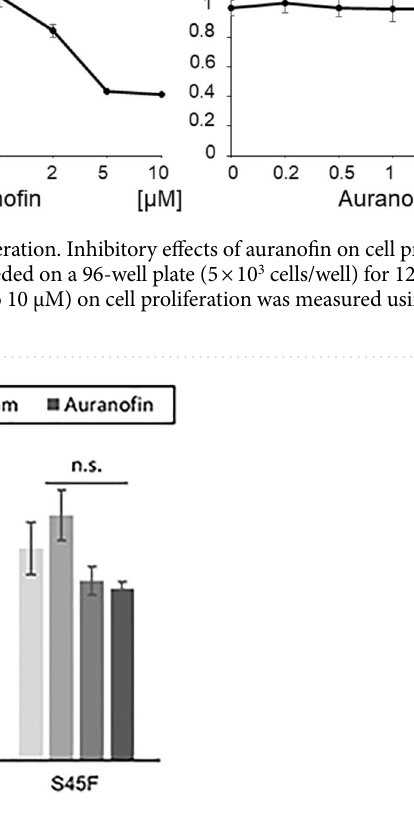
Figure 3. Apoptosis assay for DF cells under drug administration. The DF cells (WT, T41A, and S45F) were seeded on a 96-well plate (5 × 10 3 cells/well) for 12 h. Thereafter, the effects of auranofin, felodipine,